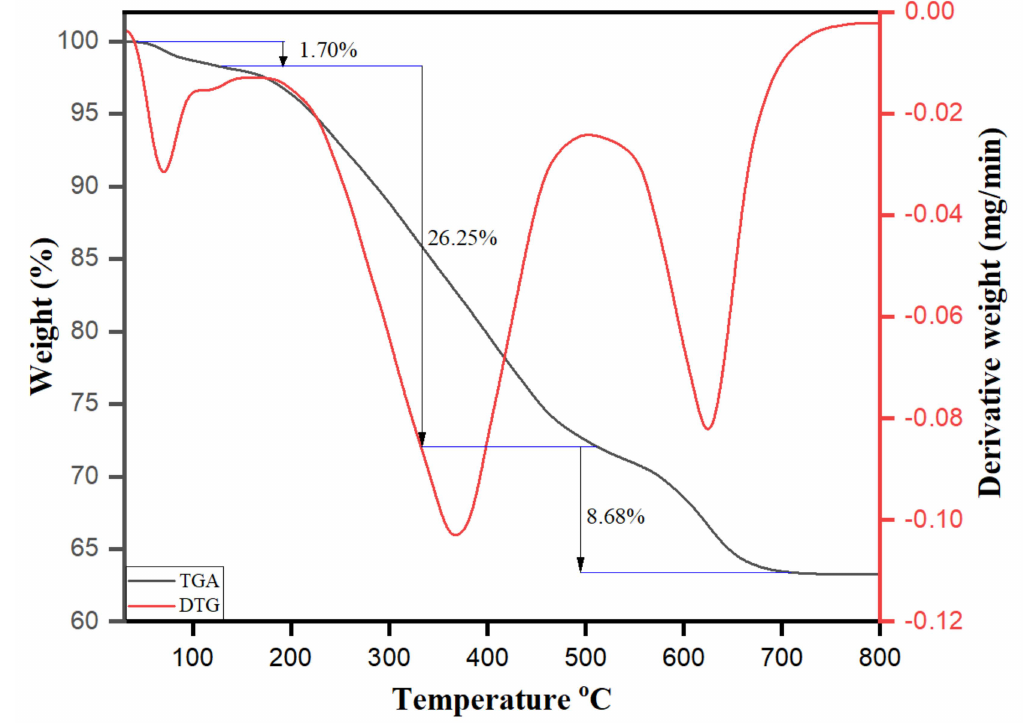
Figure 11. TGA / DTG thermogram of biomolecule-capped